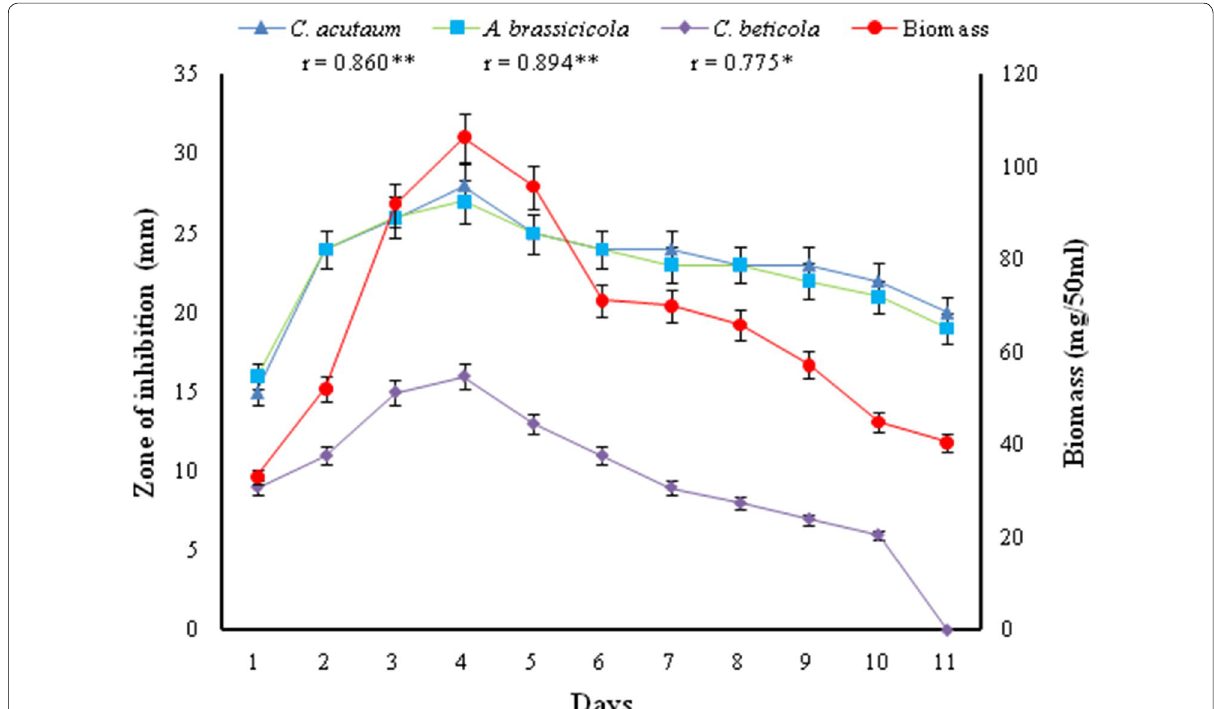
Fig. 4 Growth and antifungal activity of Streptomyces sp. MR14 against different phytopathogens; **correlation is significant at 0.01% level; *correlation is significant at 0.05%